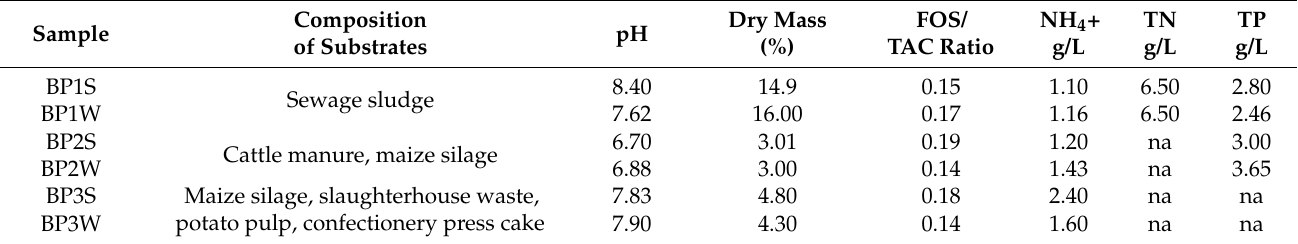
Table 1. Characteristics and composition of the examined digestate